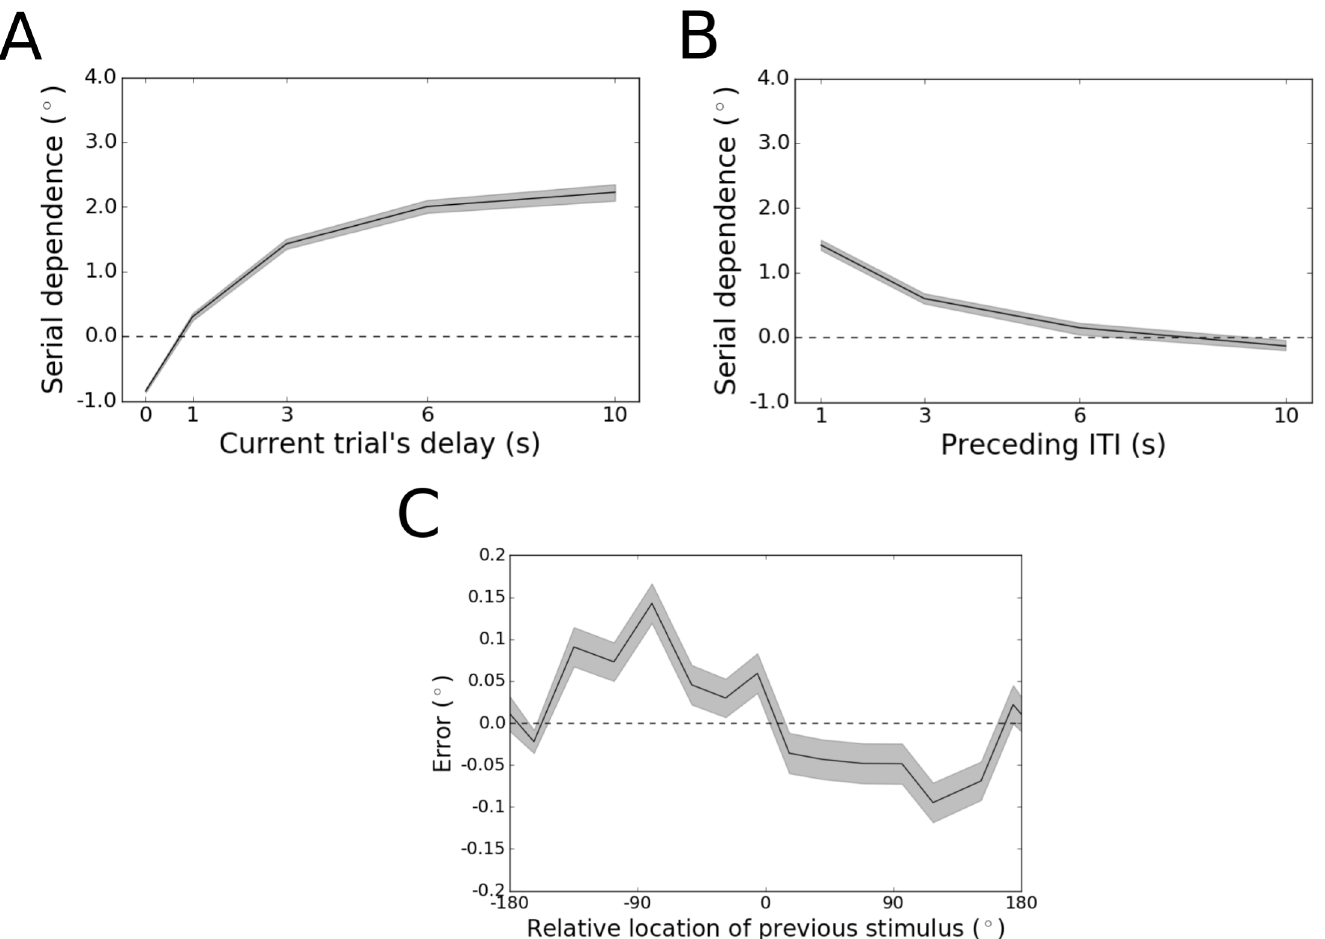
Fig 4. Results for Model 3 after accounting for adaptation. (A) Peak-to-peak of the DoG fit across the workingmemory delay. Shadingrepresents bootstrapped 95% confidenceintervals. Immediatelyafter stimulus offset (0 s delay), repulsive sensory adaptationdominates (negativeserial dependence). After 1 s of an imposedworkingmemory delay, however,the effect flips to positive serial dependence, consistent with the human data. Serial dependencethen increasesgraduallyover time before reachingan asymptote within 10 s. (B) Peak-to-peak of the DoG fit across different ITIs. When the ITI is increasedfrom 1 to 10 s, serial dependence becomes monotonically weaker until it is replacedby repulsiveadaptation, again consistent with human behavioral results. (C) Tuning of adaptation across angulardifferences betweenconsecutive stimuli for the 10-s ITI condition.The black trace depicts mean error, and the shadingdepicts the standarderror of the mean. Althoughthe magnitudeof adaptation is weak (as in the human data), the repulsivedeflectionof errors is clearly present.